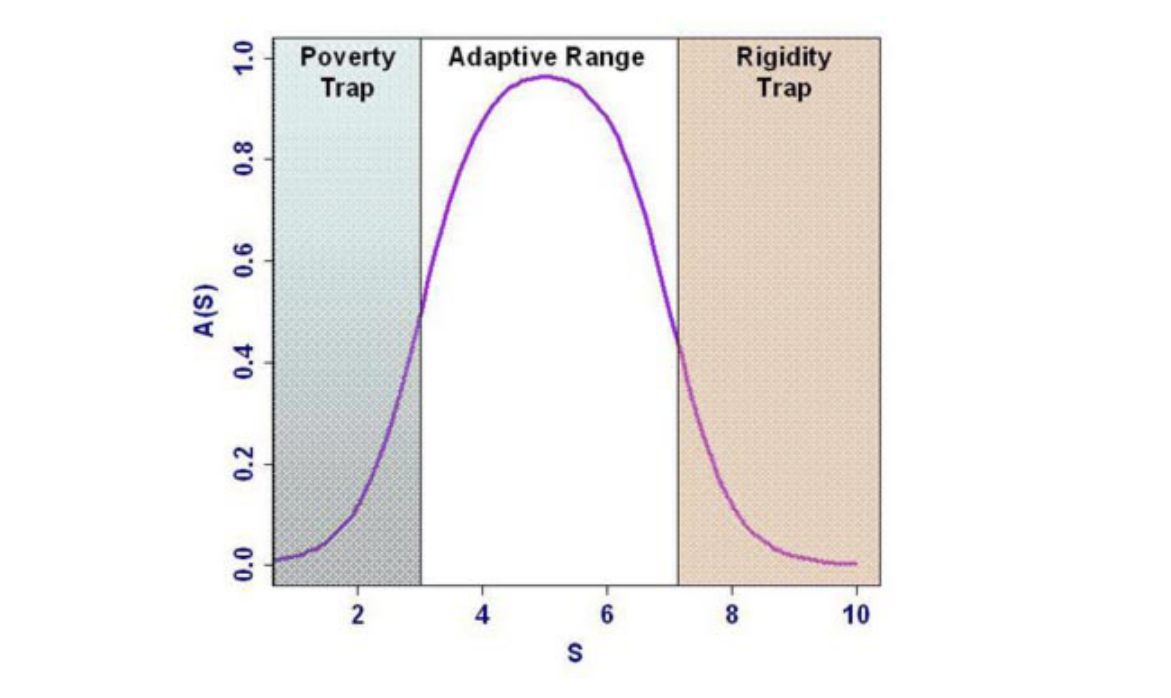
Fig. 1. The adaptive capacity function A(S) vs.